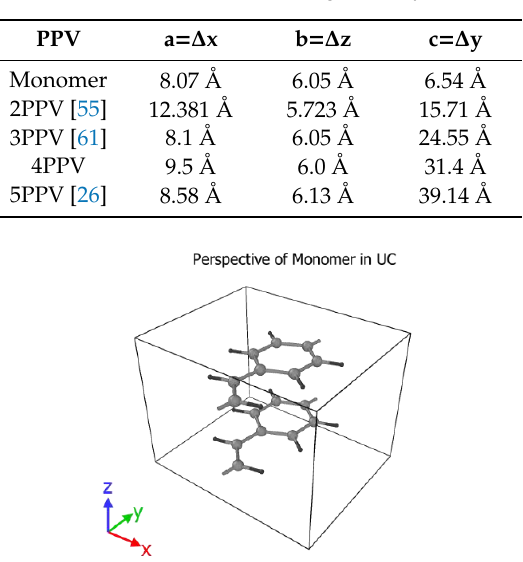
Figure 9. Supercell with wrapped molecules at periodic boundaries.